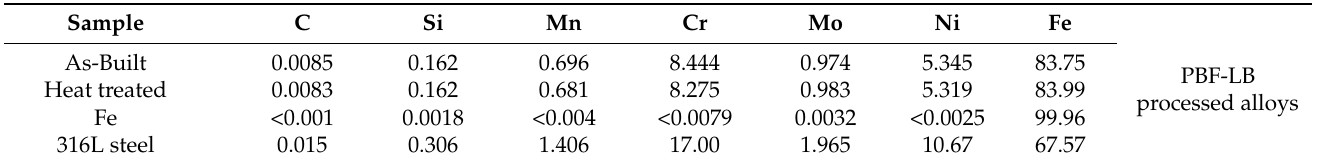
Table 6. Chemical composition (in wt.%) of the as-built and heat-treated samples compared to the raw materials.